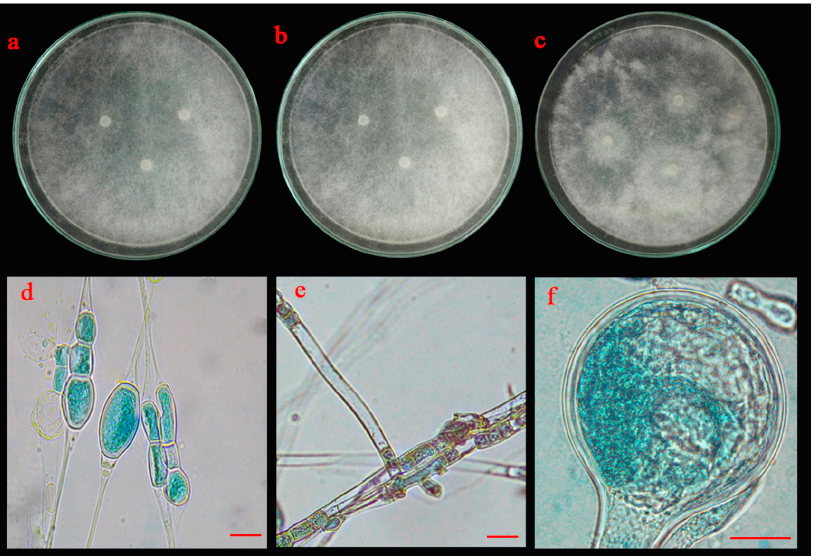
Fig. 5.(A). Morphological characteristics of UD02 isolate: colonies of UD02 isolate on three different media (a; PDA, b; MEA and c; CYA medium); chlamydospores (d), sporangiophore with lake of rhizoid (e) and sporangia and sporangiospore (f); the scale bar = 10 µm.